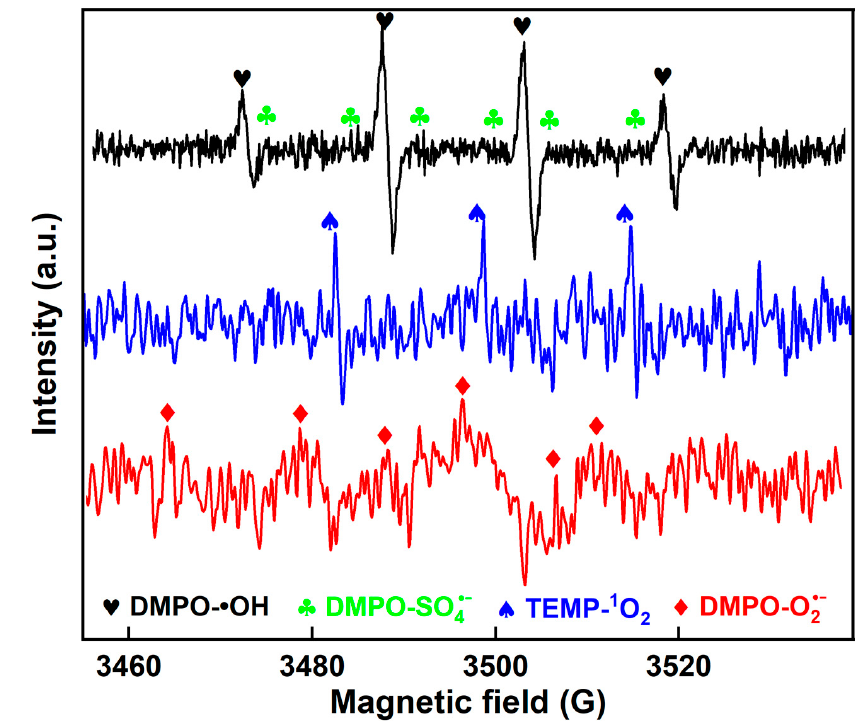
Figure 9. EPR spectra for •OH, SO 4 ●− , O 2 ●− and 1 O 2 in the LLC800/PS system.